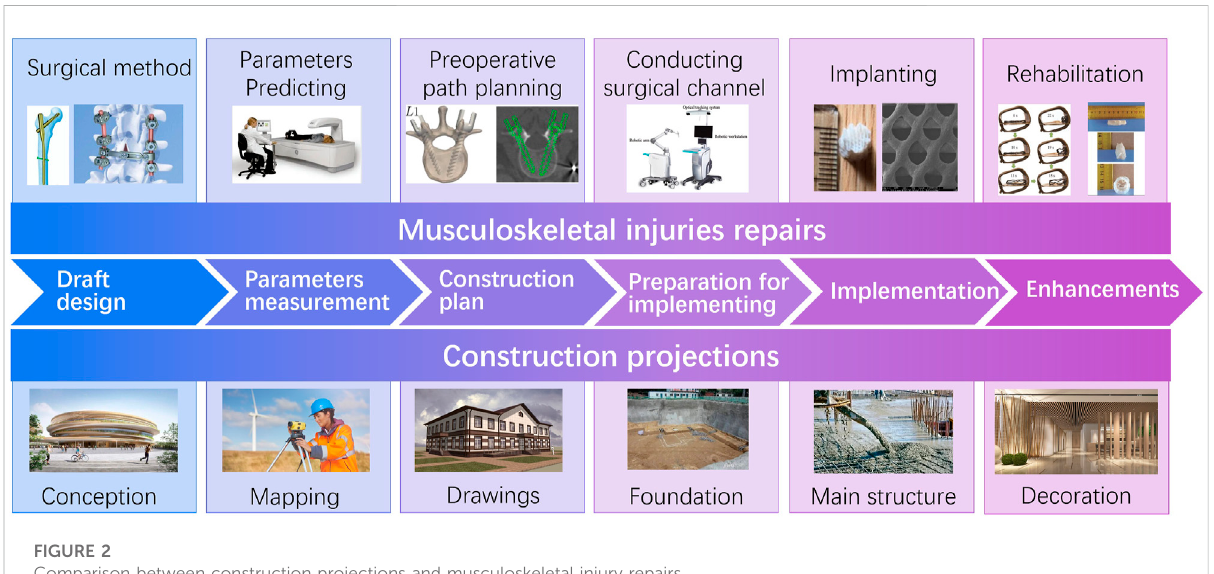
FIGURE 2 Comparison between construction projections and musculoskeletal injury repairs.